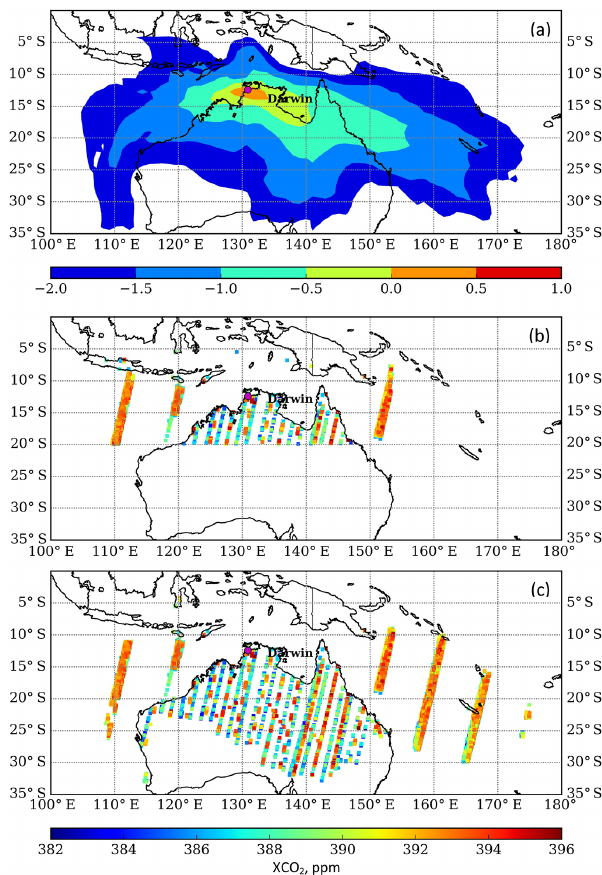
Figure 6. (a) Annual average footprint for the Darwin TCCON ob- servation site; ACOS GOSAT XCO 2 observations selected using (b) the geostatistical method within an area of ± 7.5 ◦ ×± 22.5 ◦ and (c) the footprint-based method with the limit log 10 ( x ) =− 2.0.